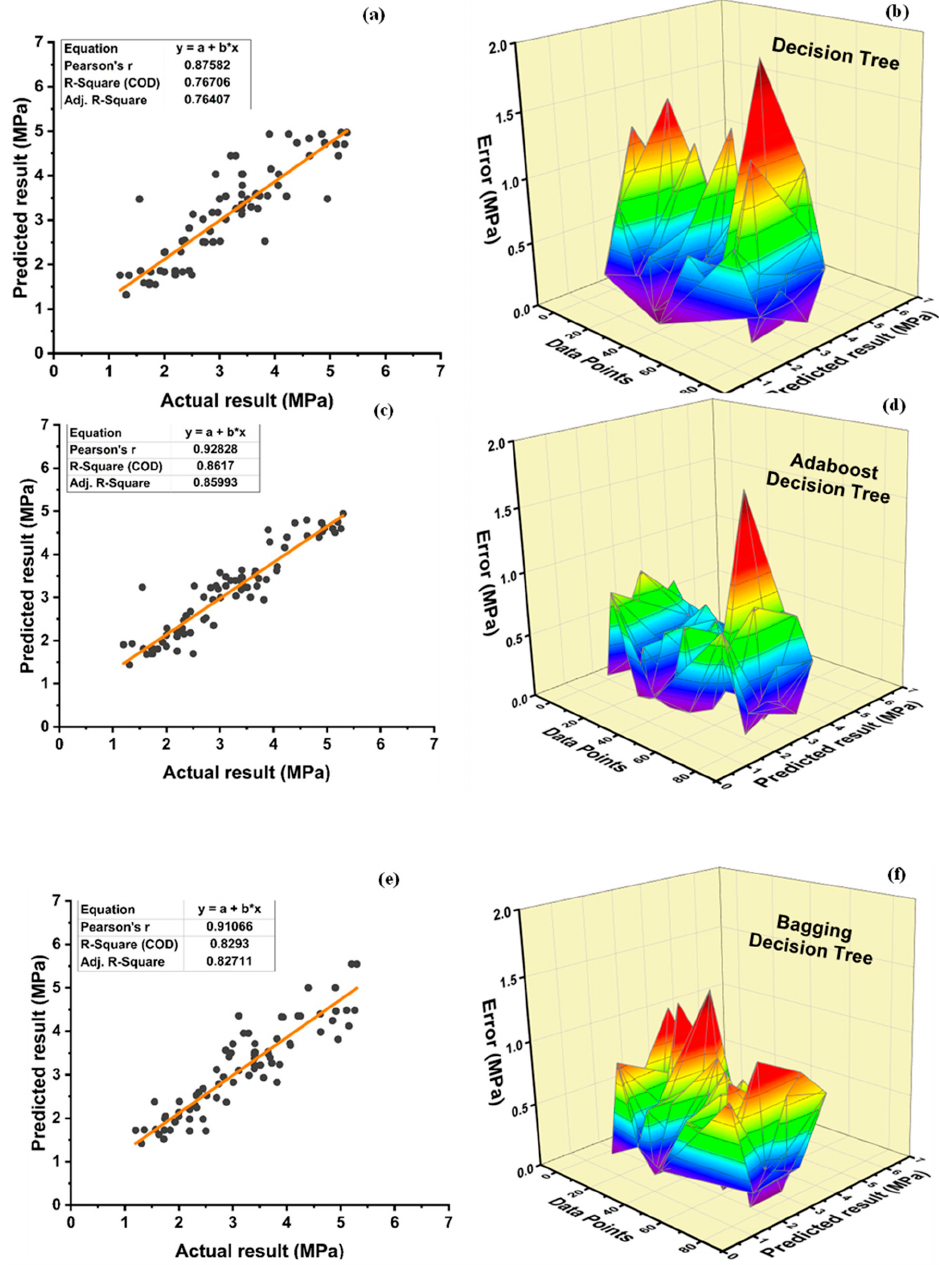
Figure 13. Tensile strength: ( a ) DT regression model; ( b ) DT model error distribution; ( c ) DT-adaboost model; ( d ) DT-adaboost model error distribution; ( e ) DT-bagging regression model; and ( f ) DT-bagging model error distribution.